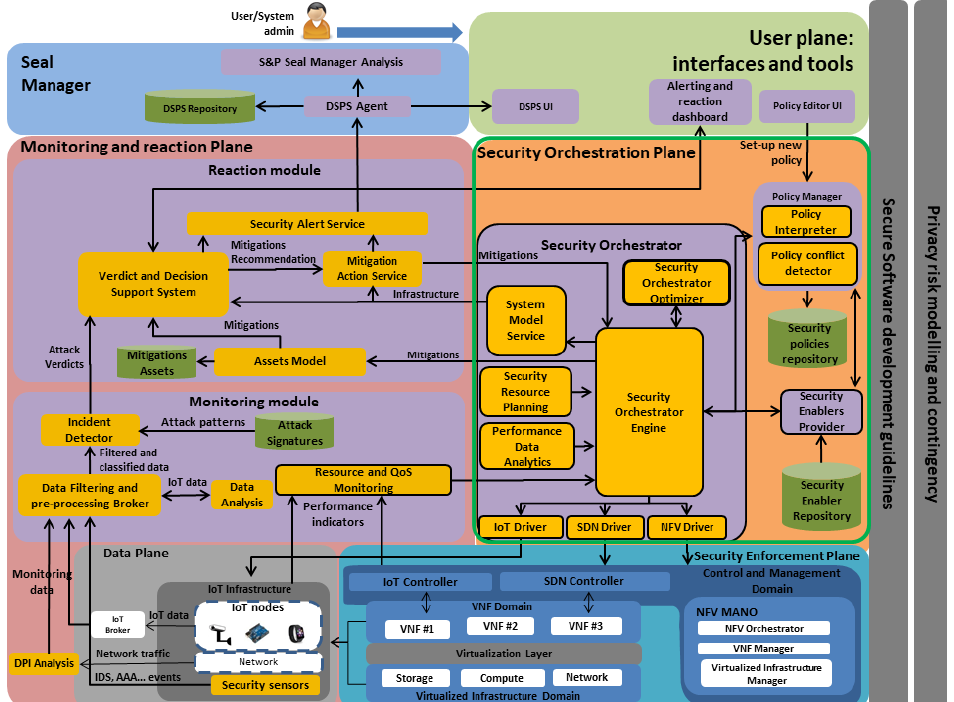
Figure 1. Proposed security Orchestration plane scoped in H2020 ANASTACIA